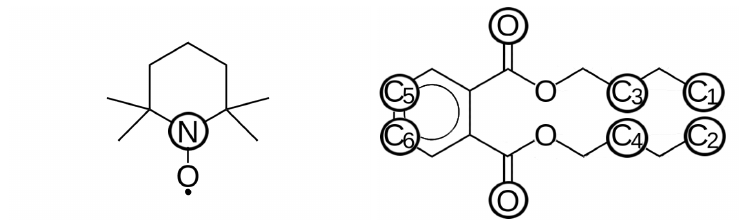
Figure 1. Structure of TEMPO and dibutyl phthalate molecules with positions and labels of atoms used in